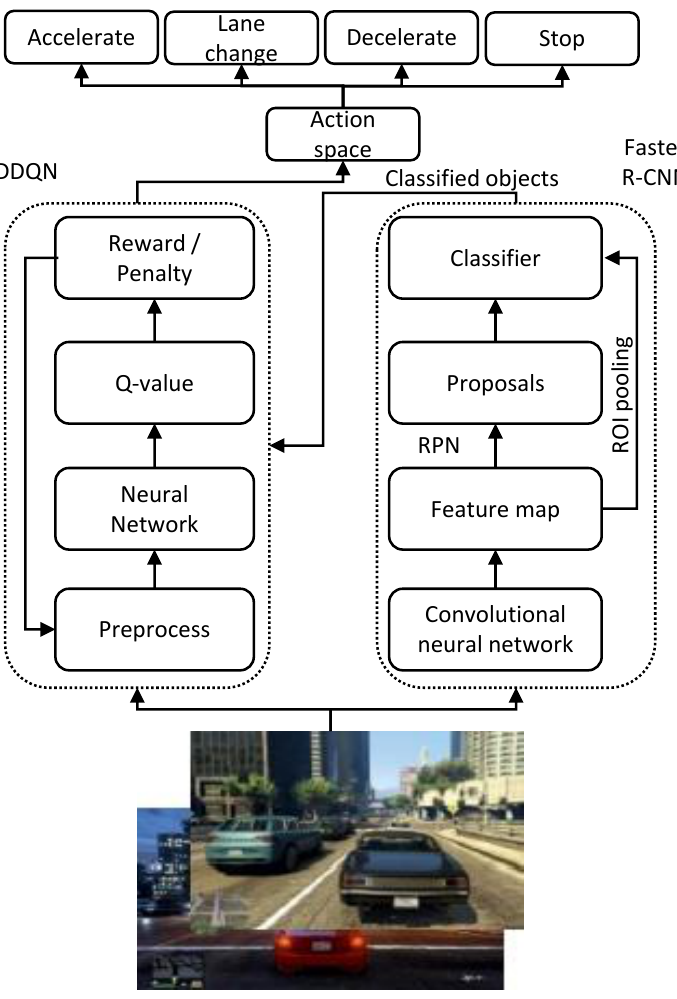
Figure 1. Proposed architecture of autonomous vehicle navigation and obstacle avoidance in dynamic